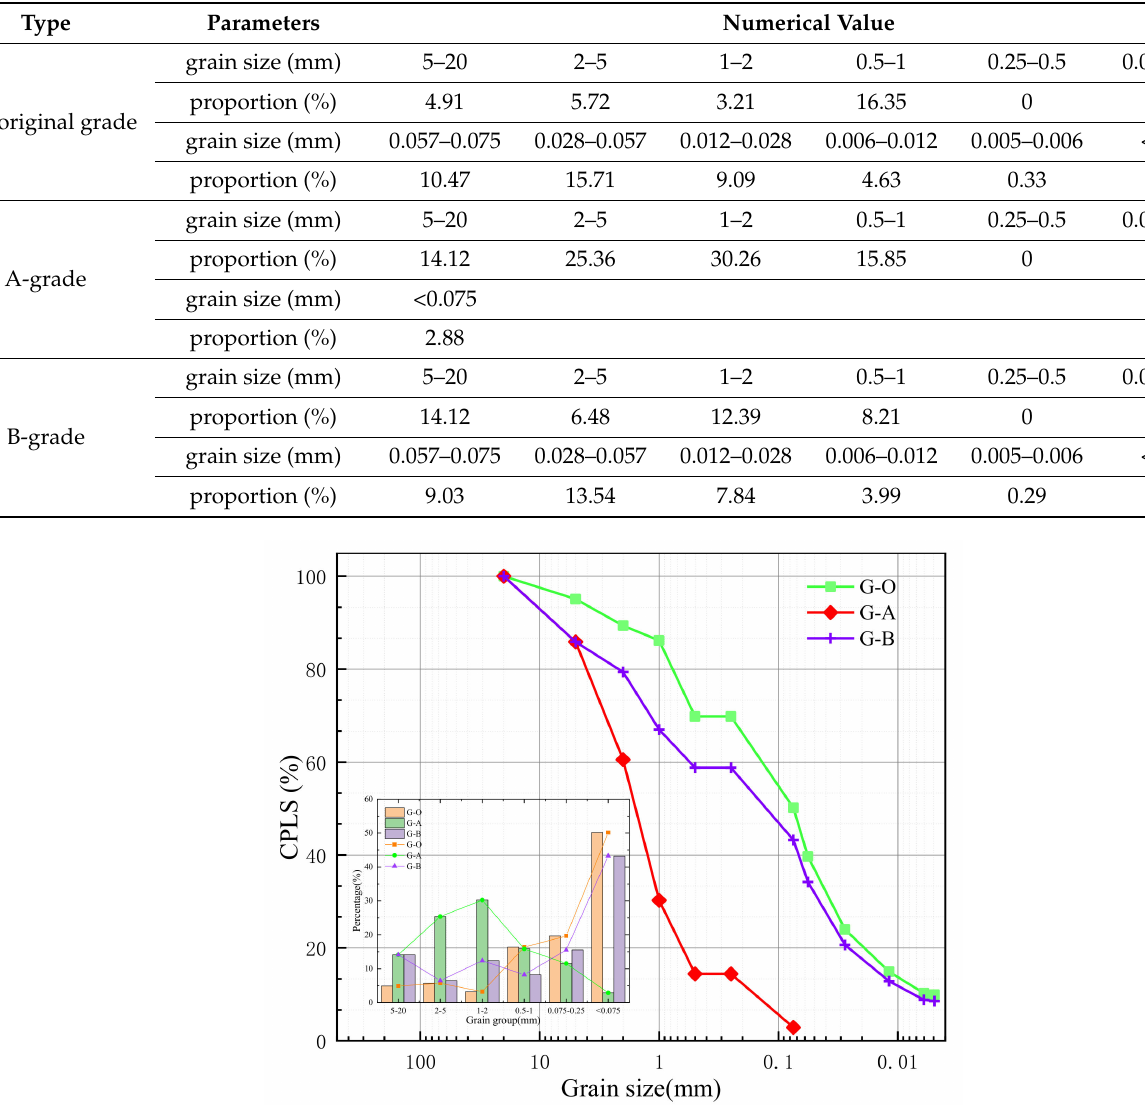
Figure 2. Grain size distribution of the soil sample (Note: CPLS is cumulative percentage less than certain particle size; G-O denotes the original grading; G-A denotes A grading; G-B denotes B